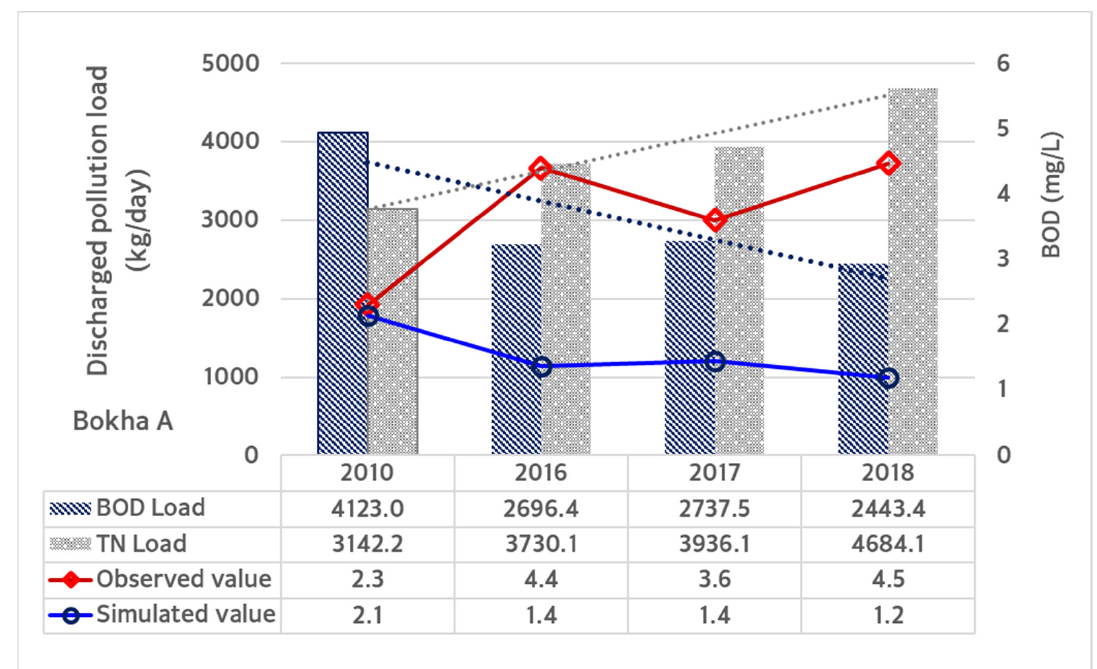
Figure 3. BOD 5 simulation results of the 1st TMDL Plan model based on 2010.